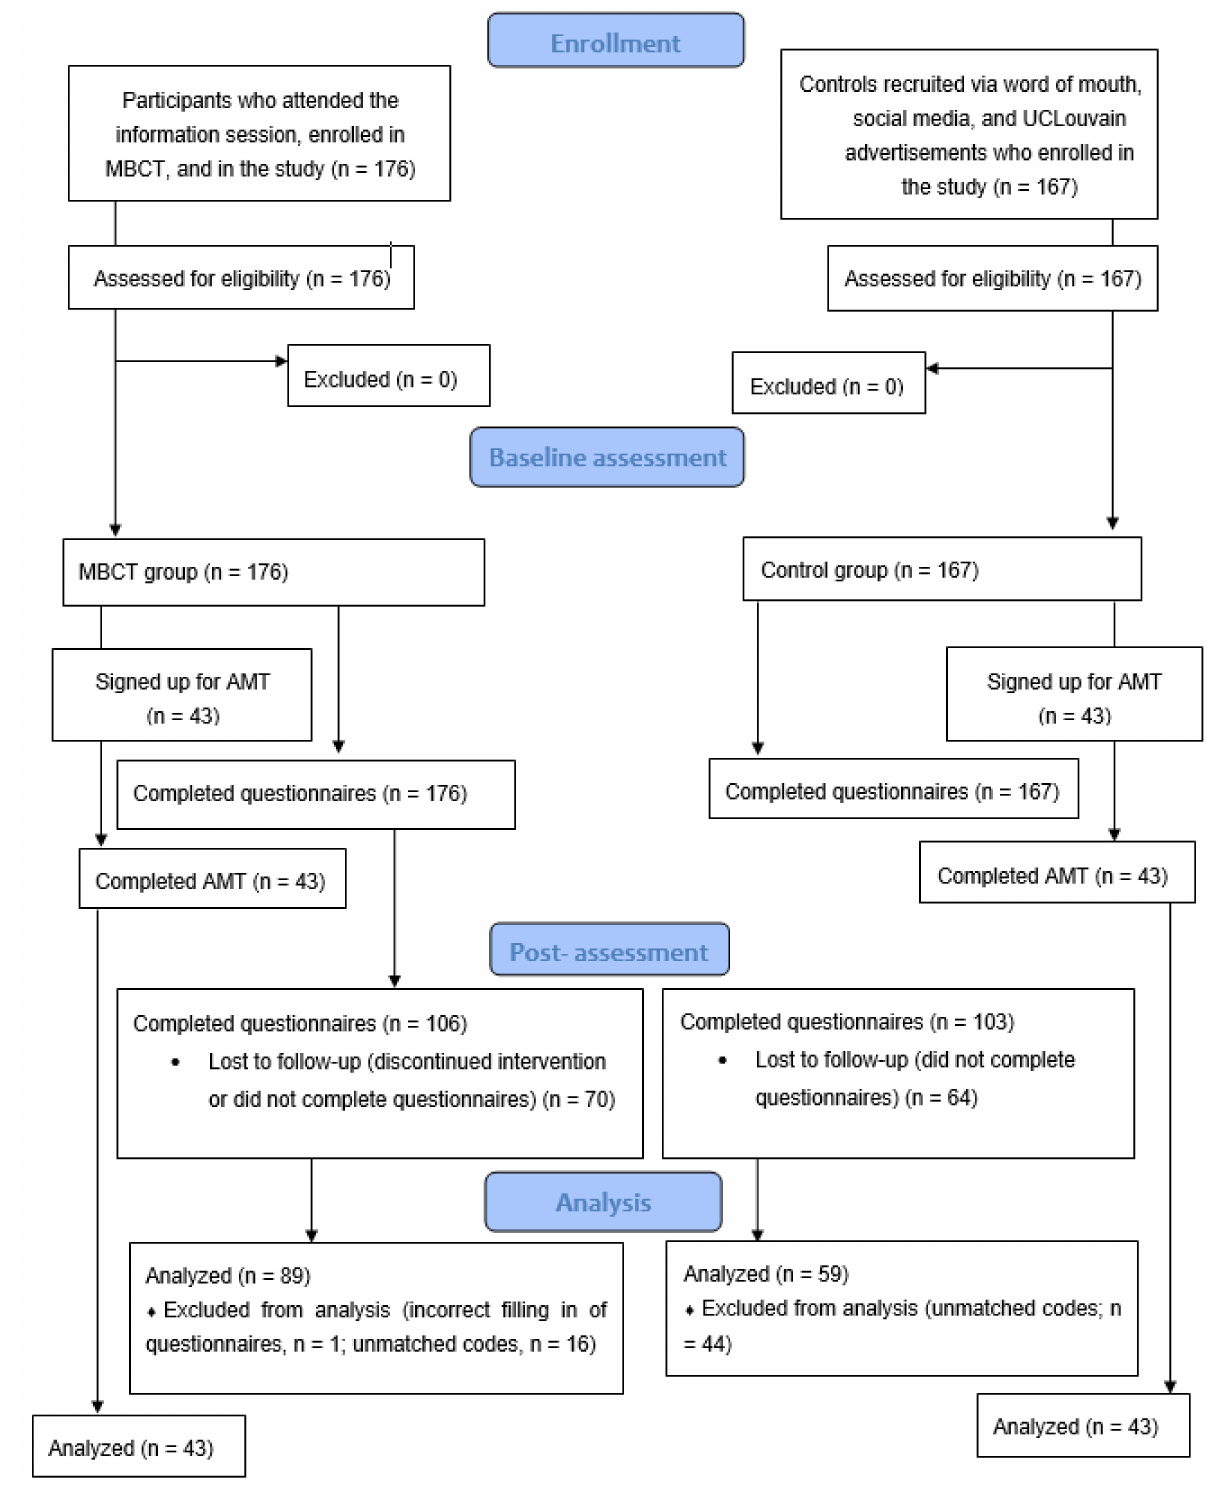
Figure 1. Flow of participants through